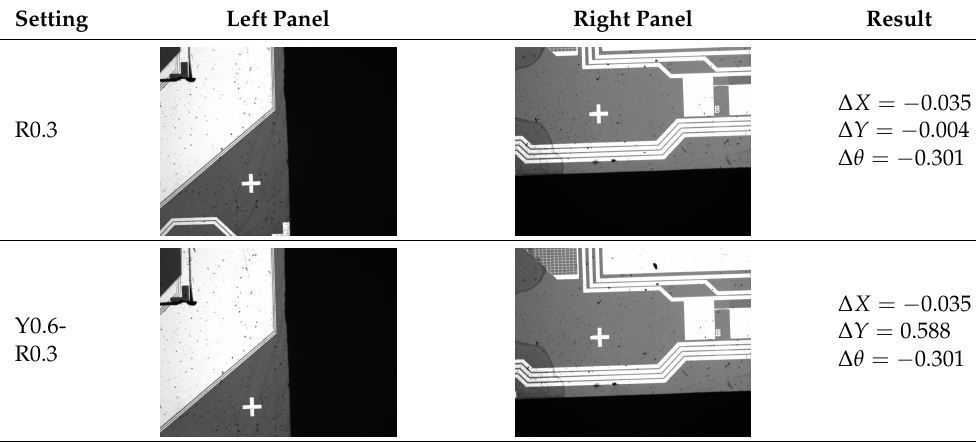
Table 4. Cont. Setting